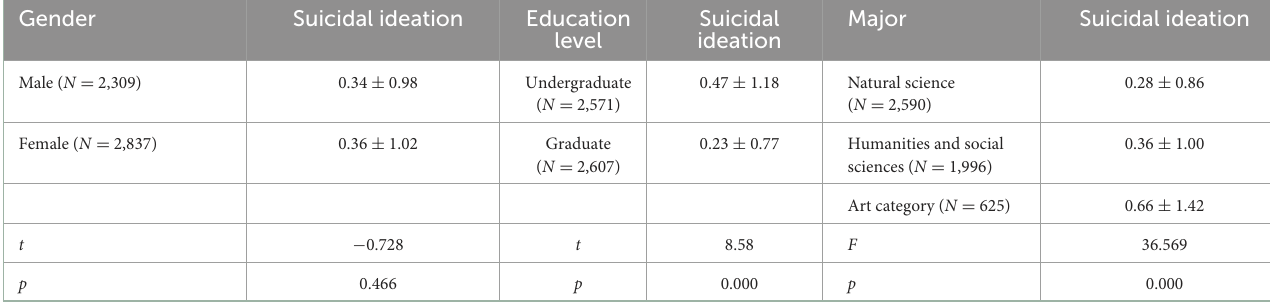
TABLE 1 Demographic characteristics of the study sample.